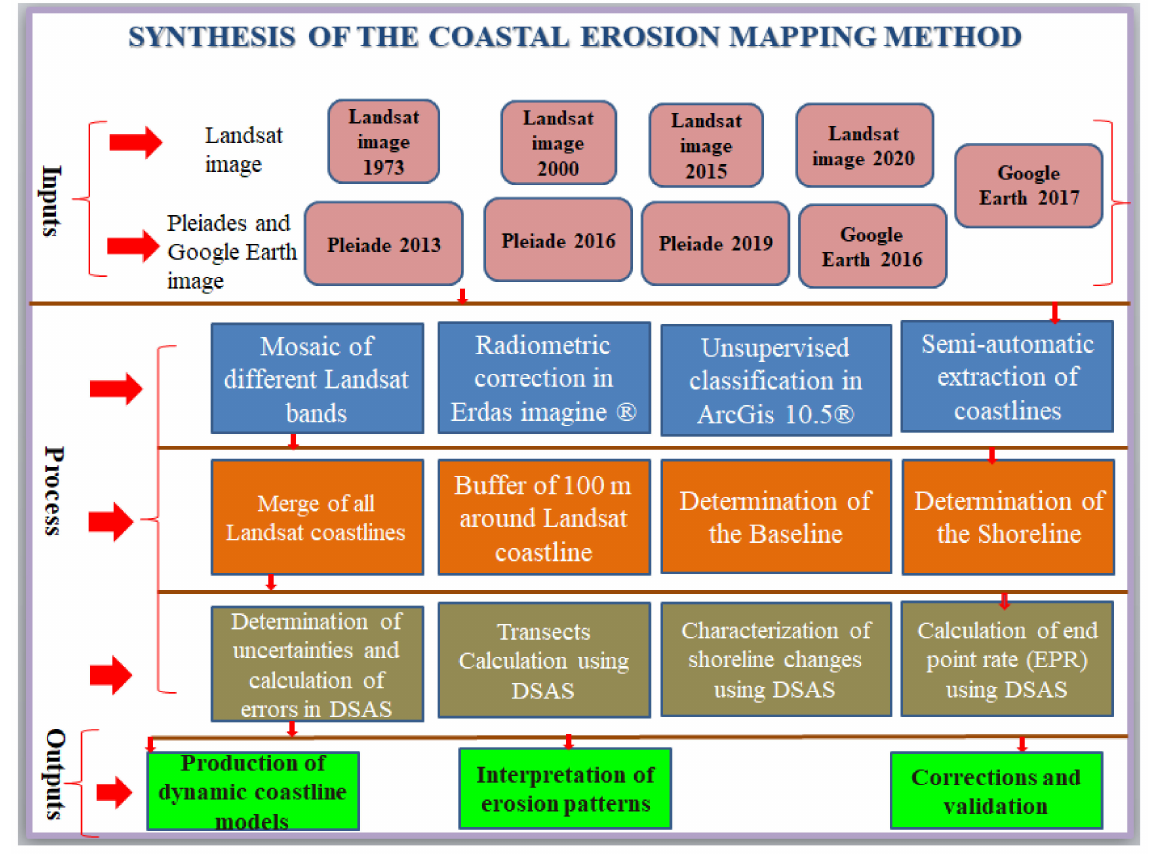
Figure 13. Flow Chart of tools and techniques used in assessing the Kribian coastal